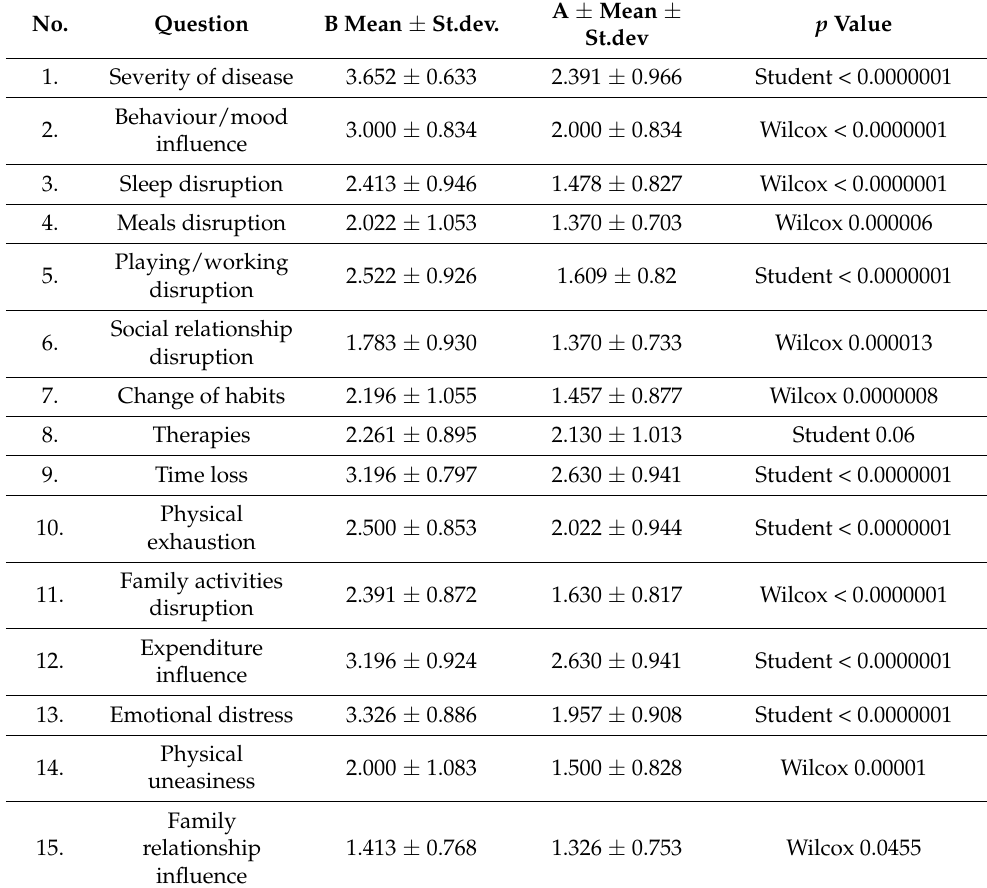
Table 2. Responses of the owners of dogs treated with allergen-specific immunotherapy (AG, No. = 46) before and after the